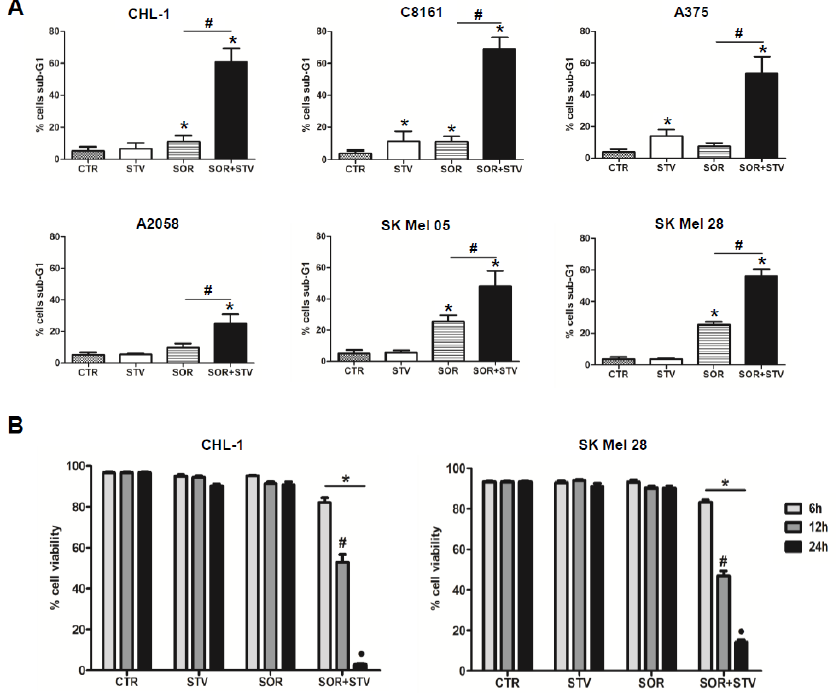
Figure 1. Combined exposure to sorafenib and starvation induces cell death in human melanoma cells. ( A ) Cell death evaluation (percentage of sub-G1 population) of PI-stained BRAF WT (CHL-1 and C8161) and oncogenic BRAF V600E (A375, A2058, SK Mel 05, and SK Mel 28) melanoma cell lines untreated (CTR) or exposed to EBSS (STV), sorafenib (SOR 10 mM) and SOR + STV for 24 h. (Histograms represent mean ± SD, n = 3) * p < 0.0001 compared to control cells; # p < 0.0001 compared to sorafenib-treated cells. One-way ANOVA, Bonferroni post-test. ( B ) Cell viability was analyzed in CHL-1 and SK Mel 28 cells at 6, 12, and 24 h of STV, SOR, and SOR + STV post treatment. (Histograms represent mean ± SD) * p < 0.0001 compared to control cells. # p < 0.0001 compared to 6h; • p < 0.0001 compared to 6 and 12 h. Two-way ANOVA, Bonferroni